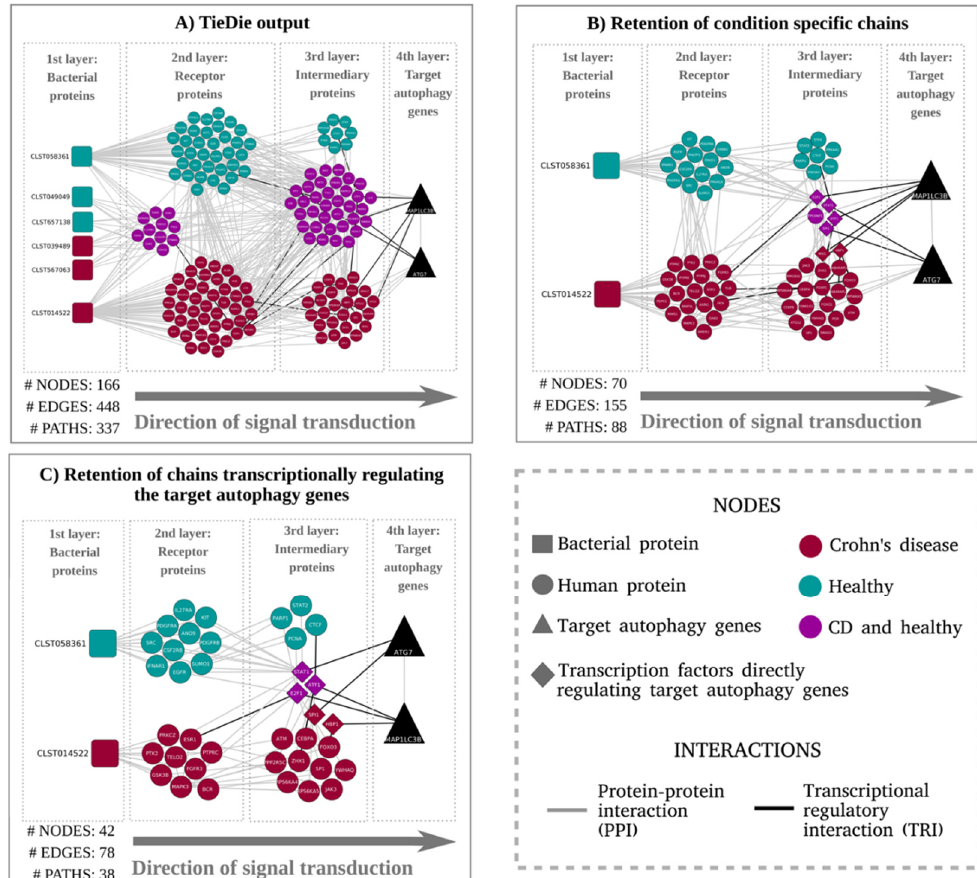
Figure 2. ( A ) Graphical representation of the signaling paths between curated receptor proteins (host proteins predicted to be modulated by microbial proteins) and target autophagy genes: The network compilation was performed by tracing the signaling chains from the human receptors (predicted to interact with the bacterial proteins) to the autophagy genes using the TieDIE tool which adopts a network diffusion [51]. For brevity, only the results corresponding to the domain–motif interaction analysis are discussed in the case study. ( B ) Network representing the signalling chains after exclusion of proteins connected with bacterial proteins detected in both CD and healthy conditions: Proteins present in both conditions that were retained were those directly regulating the target autophagy genes. ( C ) Network obtained by retaining only chains with transcriptional regulatory interactions between the intermediary protein (3rd layer) and the target autophagy genes (4th layer): The immediate upstream proteins from the autophagy target genes were confined to transcription factors modulating the target autophagy genes via a transcriptional regulatory interaction.